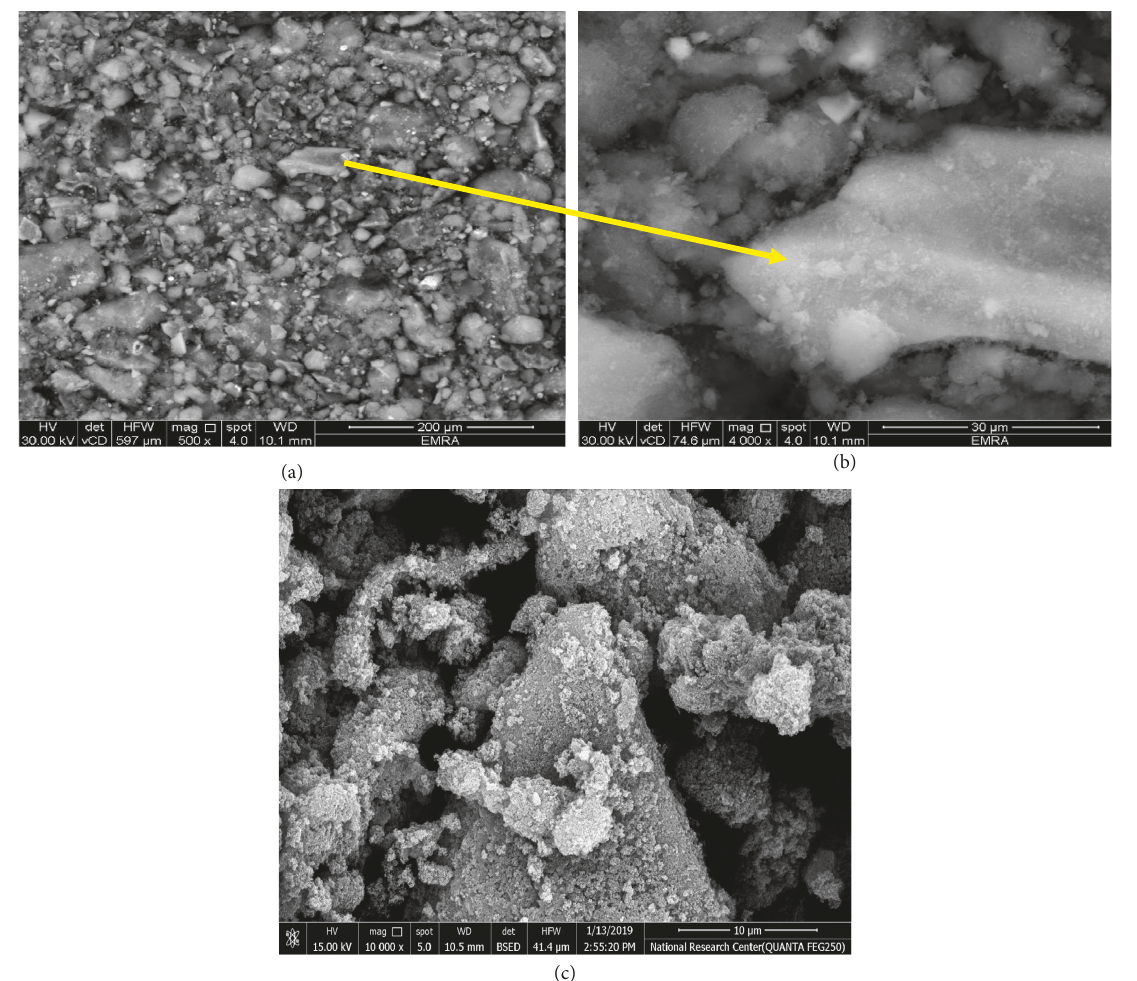
Figure 4: SEM images of the NSG nanocomposite before absorption (a) at 200 μ m and (b) at 30 μ m and (c) after